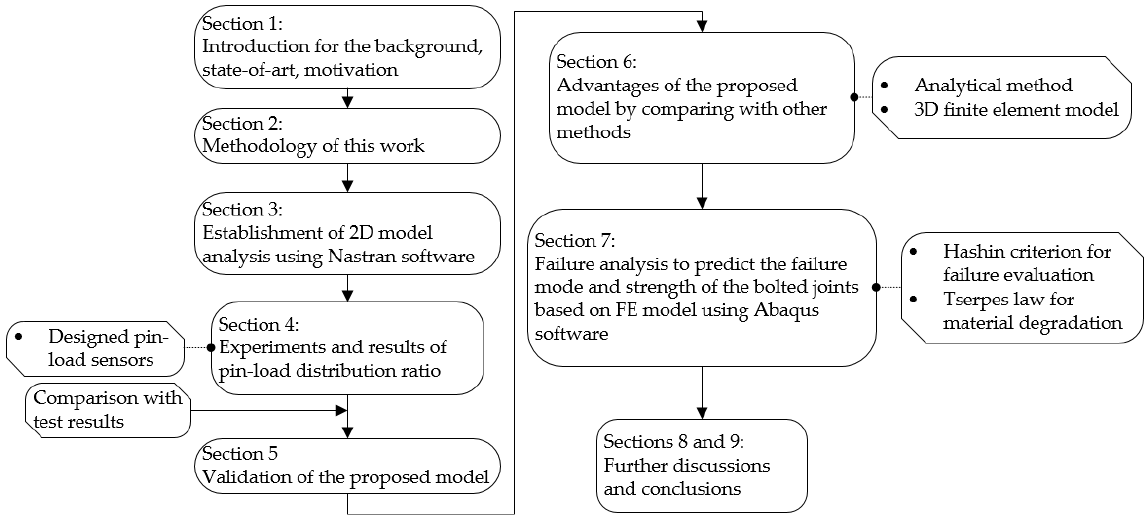
Figure 1. Main framework of this study.